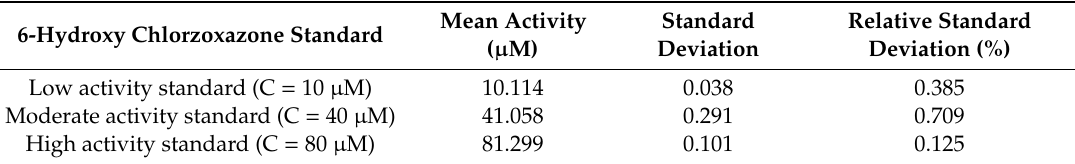
Table 4. Intra-assay variation of CYP2E1 enzyme metabolite (6-hydroxychlorzoxazone) ( n =